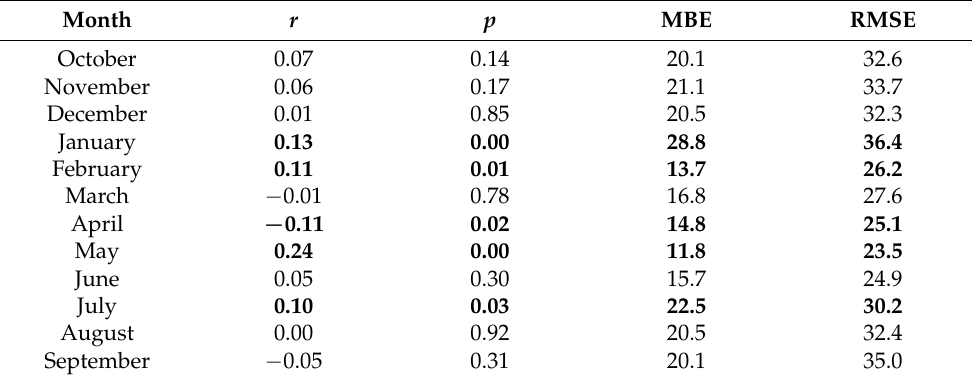
Table 4. Verification statistics for average number of low flow events calculated from the NWM retrospective simulations relative to associated USGS observations at river segments with a Strahler stream order ≥ 6. Months where the Spearman correlation coefficient is significant at p < 0.05 are in bold.